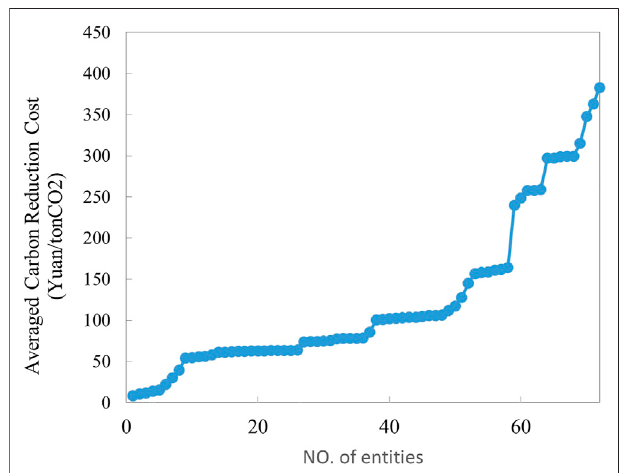
FIGURE 2 | Averaged carbon reduction cost. Data source: Local Statistical Yearbook and Bureau of